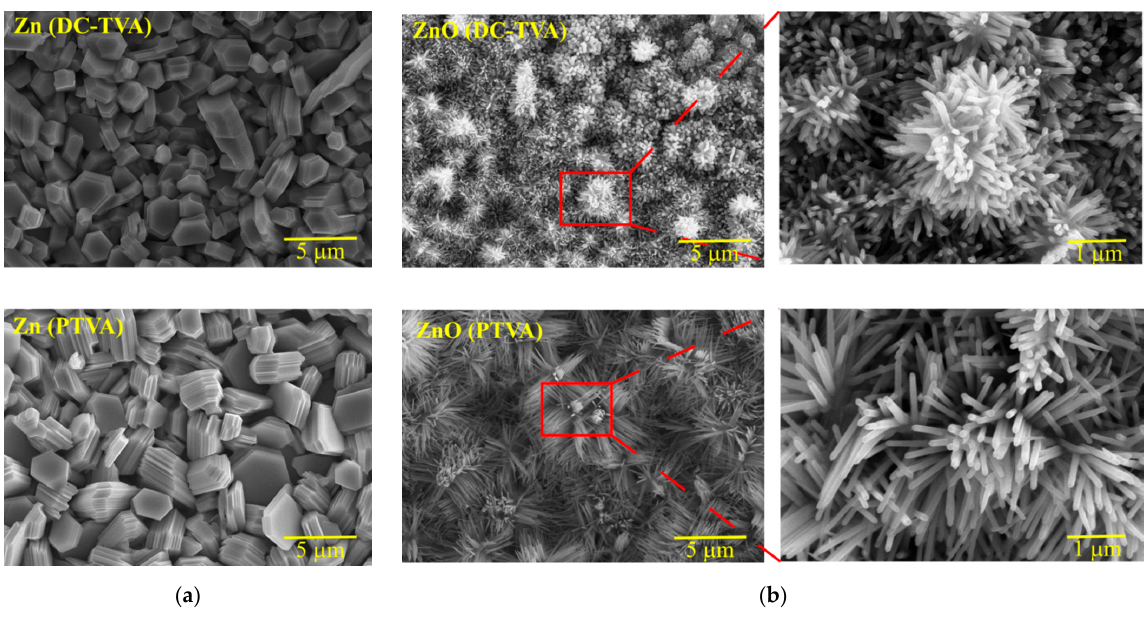
Figure 2. SEM images of the as-deposited Zn coatings ( a ) by DC-TVA and PTVA, and the corresponding ZnO nanostruc- tures ( b ) obtained after annealing in an oxygen